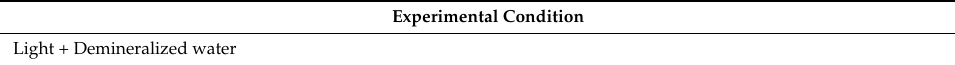
Table 1. Terpenoids moieties (3 g/L) oxidized in different experimental